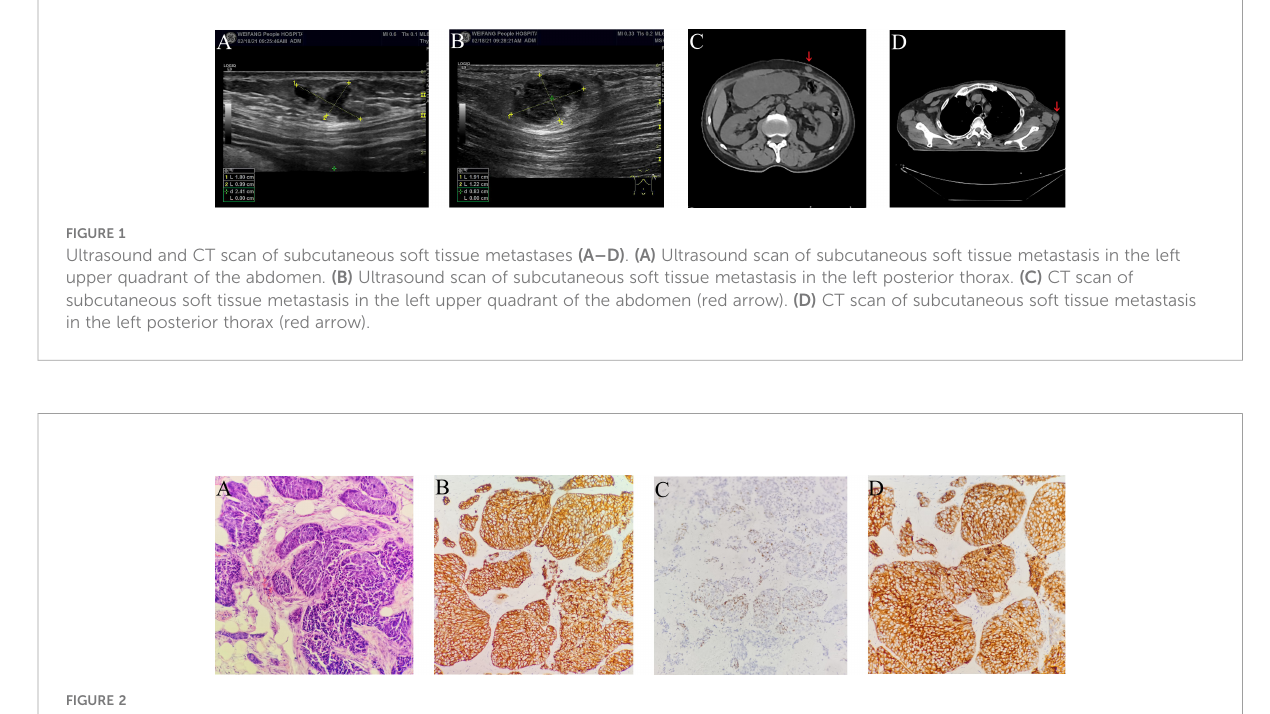
Table 1. Most patients in these reports had subcutaneous soft